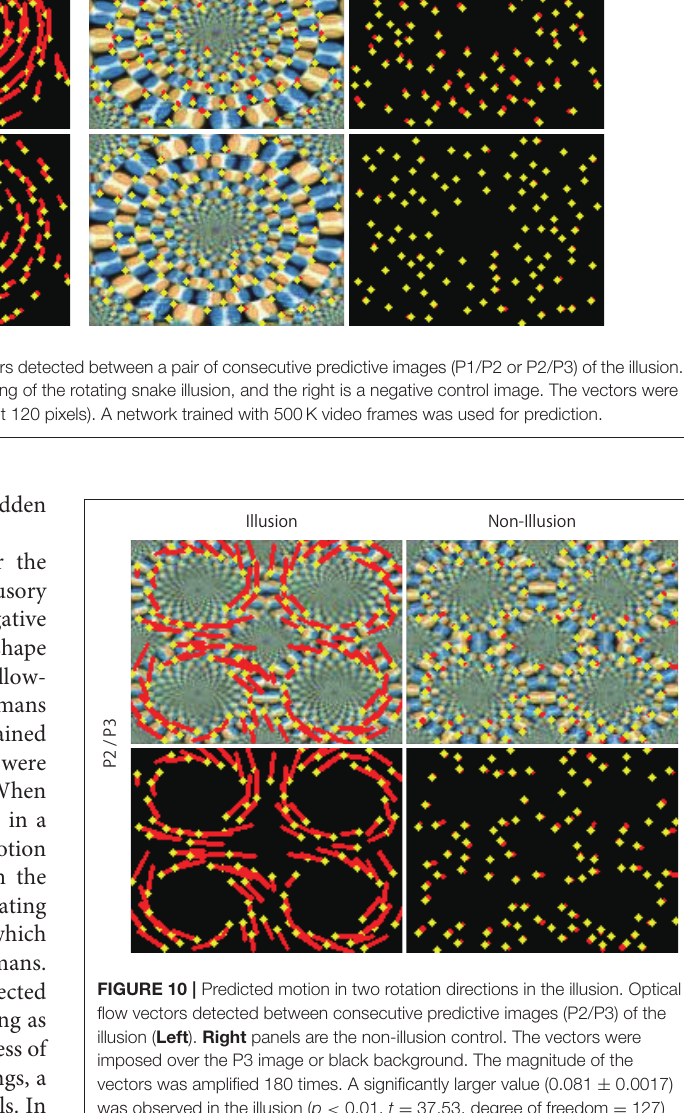
FIGURE 10 | Predicted motion in two rotation directions in the illusion. Optical flow vectors detected between consecutive predictive images (P2/P3) of the illusion ( Left ). Right panels are the non-illusion control. The vectors were imposed over the P3 image or black background. The magnitude of the vectors was amplified 180 times. A significantly larger value (0.081 ± 0.0017) was observed in the illusion ( p < 0.01, t = 37.53, degree of freedom = 127) than in the non-illusion control (mean magnitude of optical flow vectors, 0.013 ± 0.00064 pixels). The mean of magnitudes (0.080 ± 0.0025) of the vectors detected by the counter clockwise rings of the illusion was not significantly different from the value (0.081 ± 0.0023) of the clockwise rings ( p = 0.390, t = − 0.281, degree of freedom =